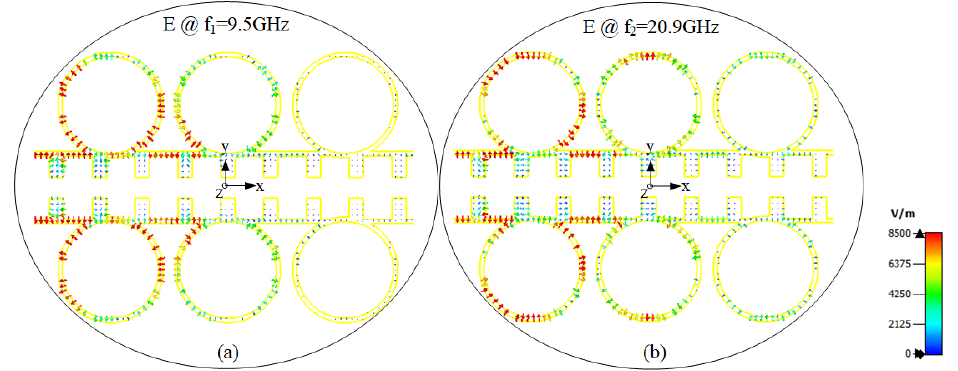
Figure 4. Electric field lines of CCRRs, ( a ) at the first resonance ( f 1 = 9.5 GHz) and ( b ) at the second resonance ( f 2 = 20.9